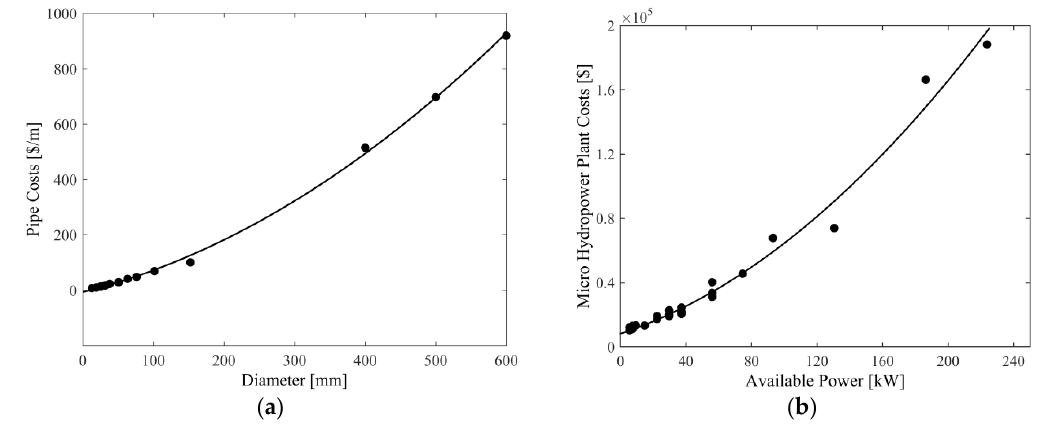
Figure 3. Design costs: ( a ) Pipes; and ( b ) Micro hydro [22].